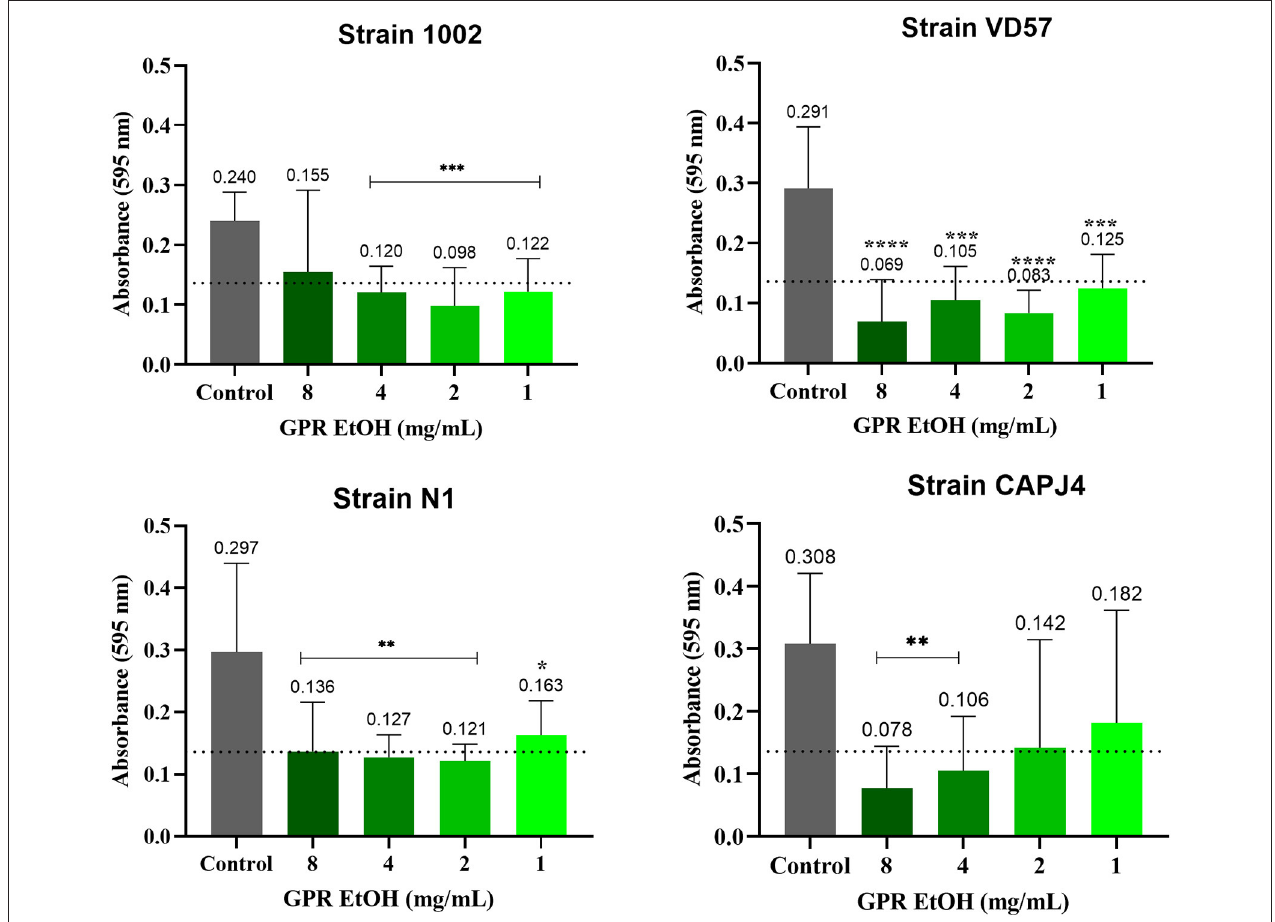
FIGURE 4 | Interference activity of the green propolis ethanolic extract (GPR EtOH) in the formation of C. pseudotuberculosis biofilm: Strain 1002, Strain N1, Strain VD57, Strain CAPJ4. The dashed line in the graphs represents the cutoff point for significant biofilm production. Asterisks indicate statistical differences between untreated and treated biofilms analyzed using the one-way ANOVA and t -tests. * p < 0.05; ** p < 0.04; *** p < 0.003; **** p < 0.0001.